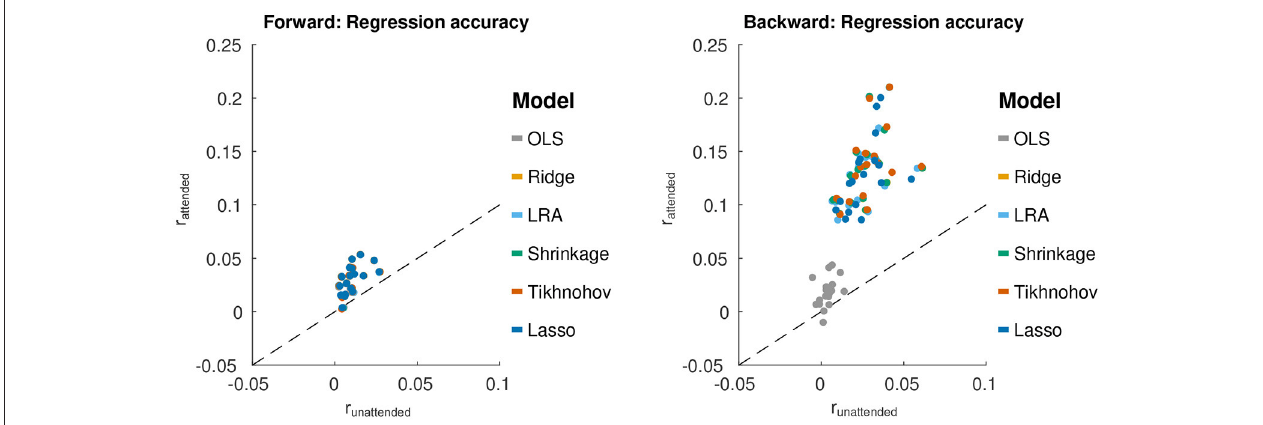
FIGURE 2 | Test set regression accuracies ( r attend ) for each forward/backward model estimation method plotted against r unattend . (Left) Results from the forward modeling approach. Points for each regularization scheme are close to each other, and thus appear to fall on top of each other. (Right) Results from the backward modeling approach. For each scheme (represented by a color), each point represents average data from one subject. The black line shows r attend = r unattend .